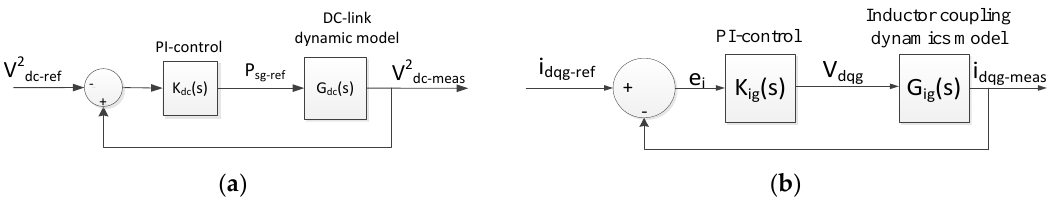
Figure 10. The control structure for grid side converter of NPC-VSC: ( a ) the DC-bus voltage control (outer loop) structure; ( b ) the current control (inner loop) structure.